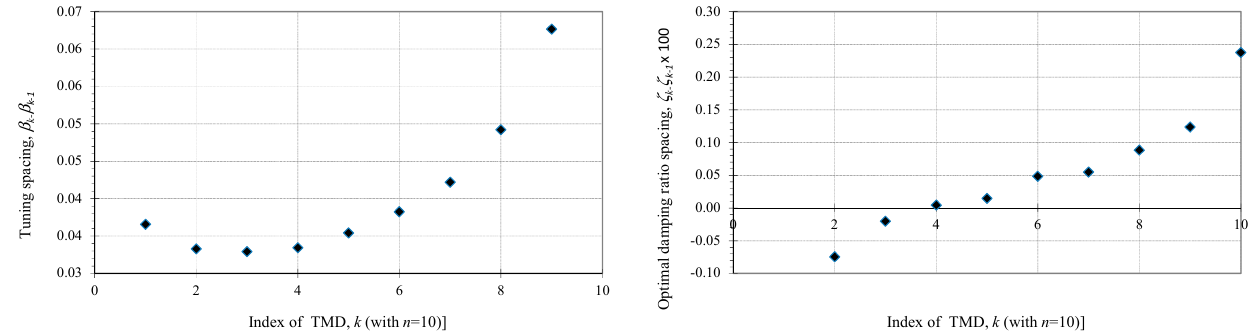
Figure 10. Optimal tuning ratios β k and damping ratios ζ k t of the individual TMD for µ = 0.05 and ζ 1 = 0 obtained on the basis of J 1.